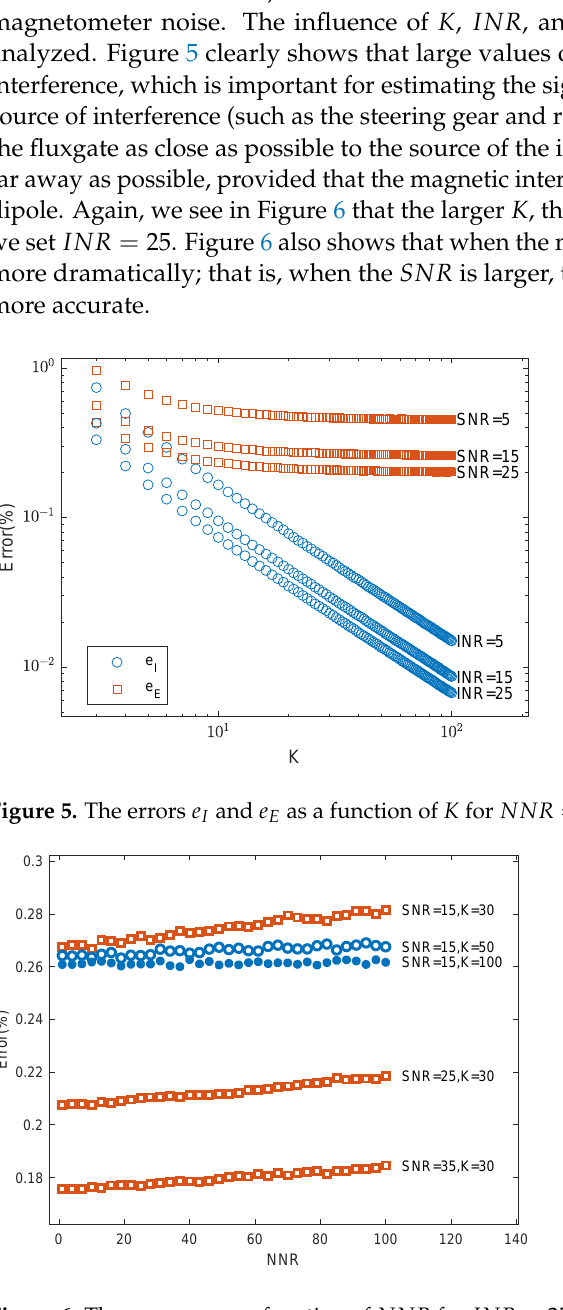
Figure 6. The errors e E as a function of NNR for INR =